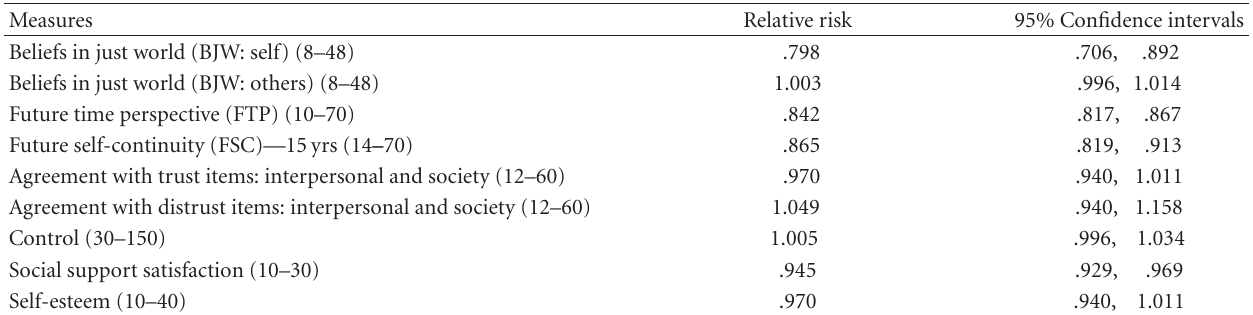
Table 3: Relative risk of death associated with beliefs in just world and other related future time perspective measures and trust measures ( N = 440) (Range of scores).